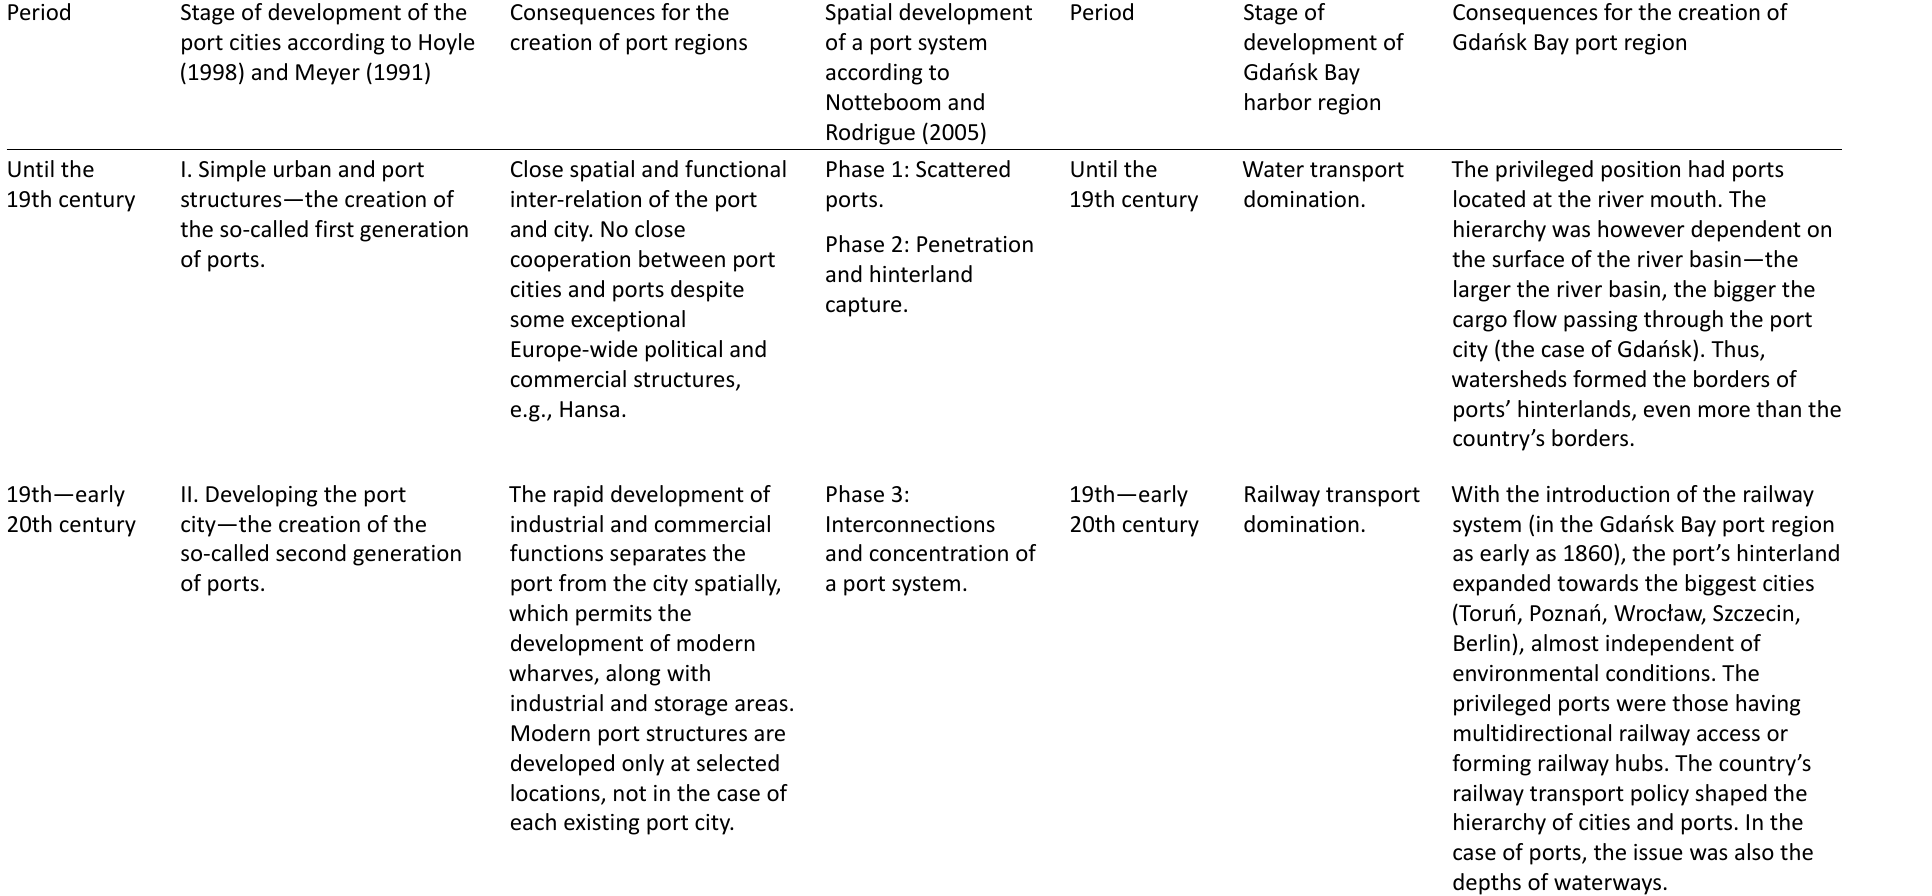
Table 1. Comparison of evolutionary stages of the port‐city interrelation.